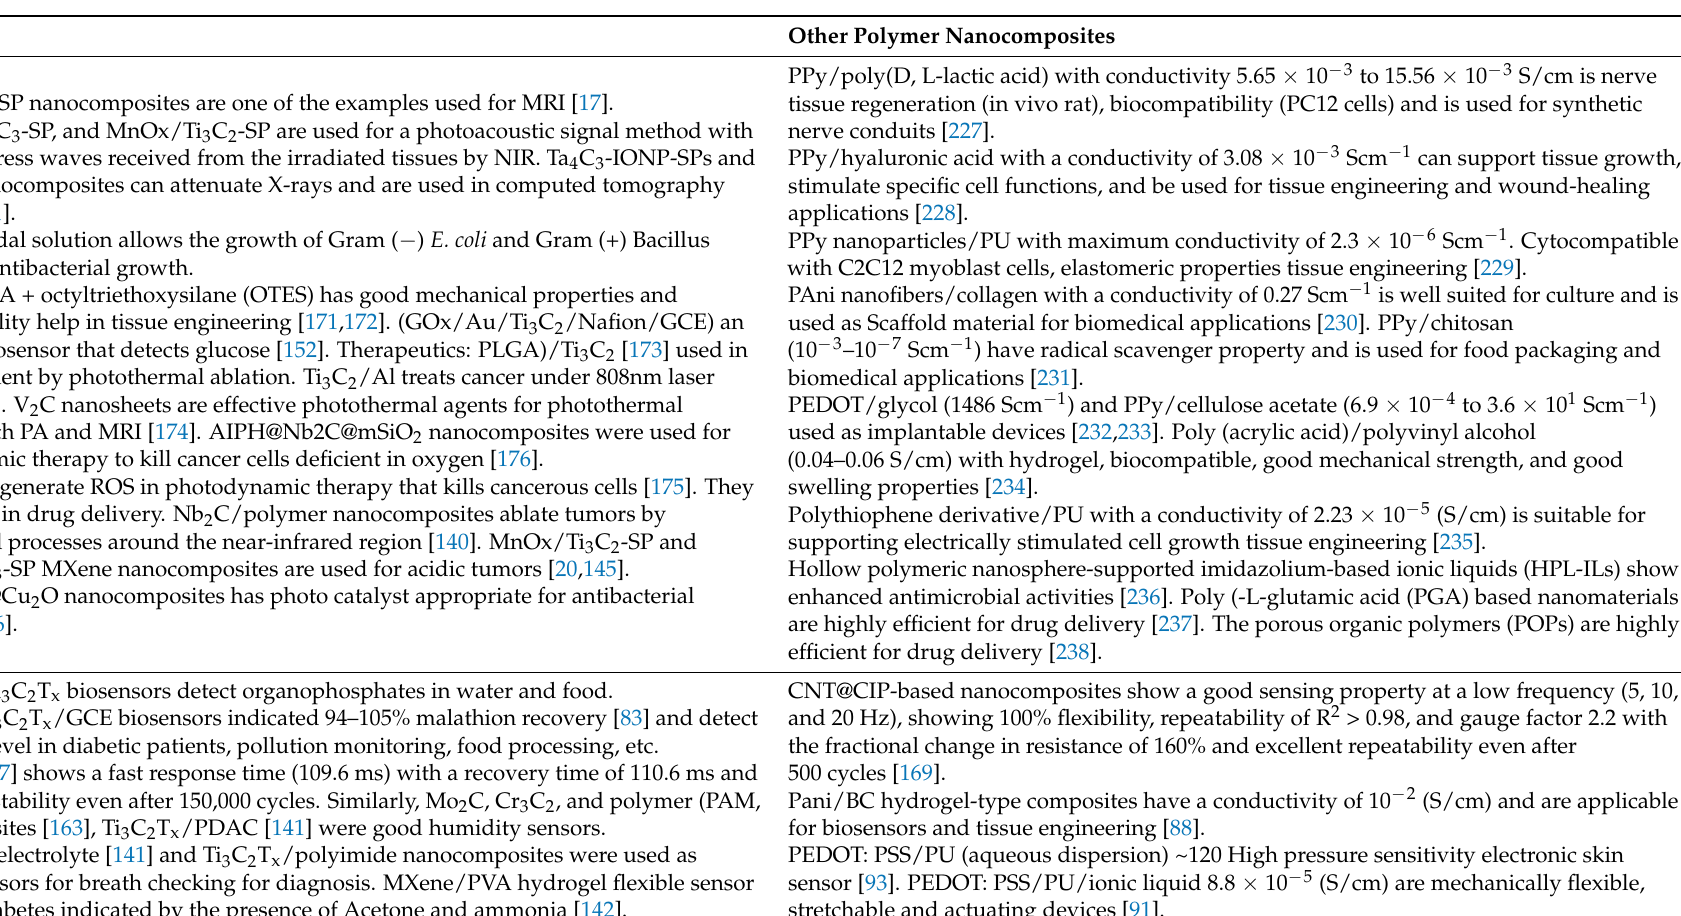
Table 2. MXene-based nanocomposites vs. other polymer nanocomposites of the same field Adopted with the permission from Ref. [223], European Polymer